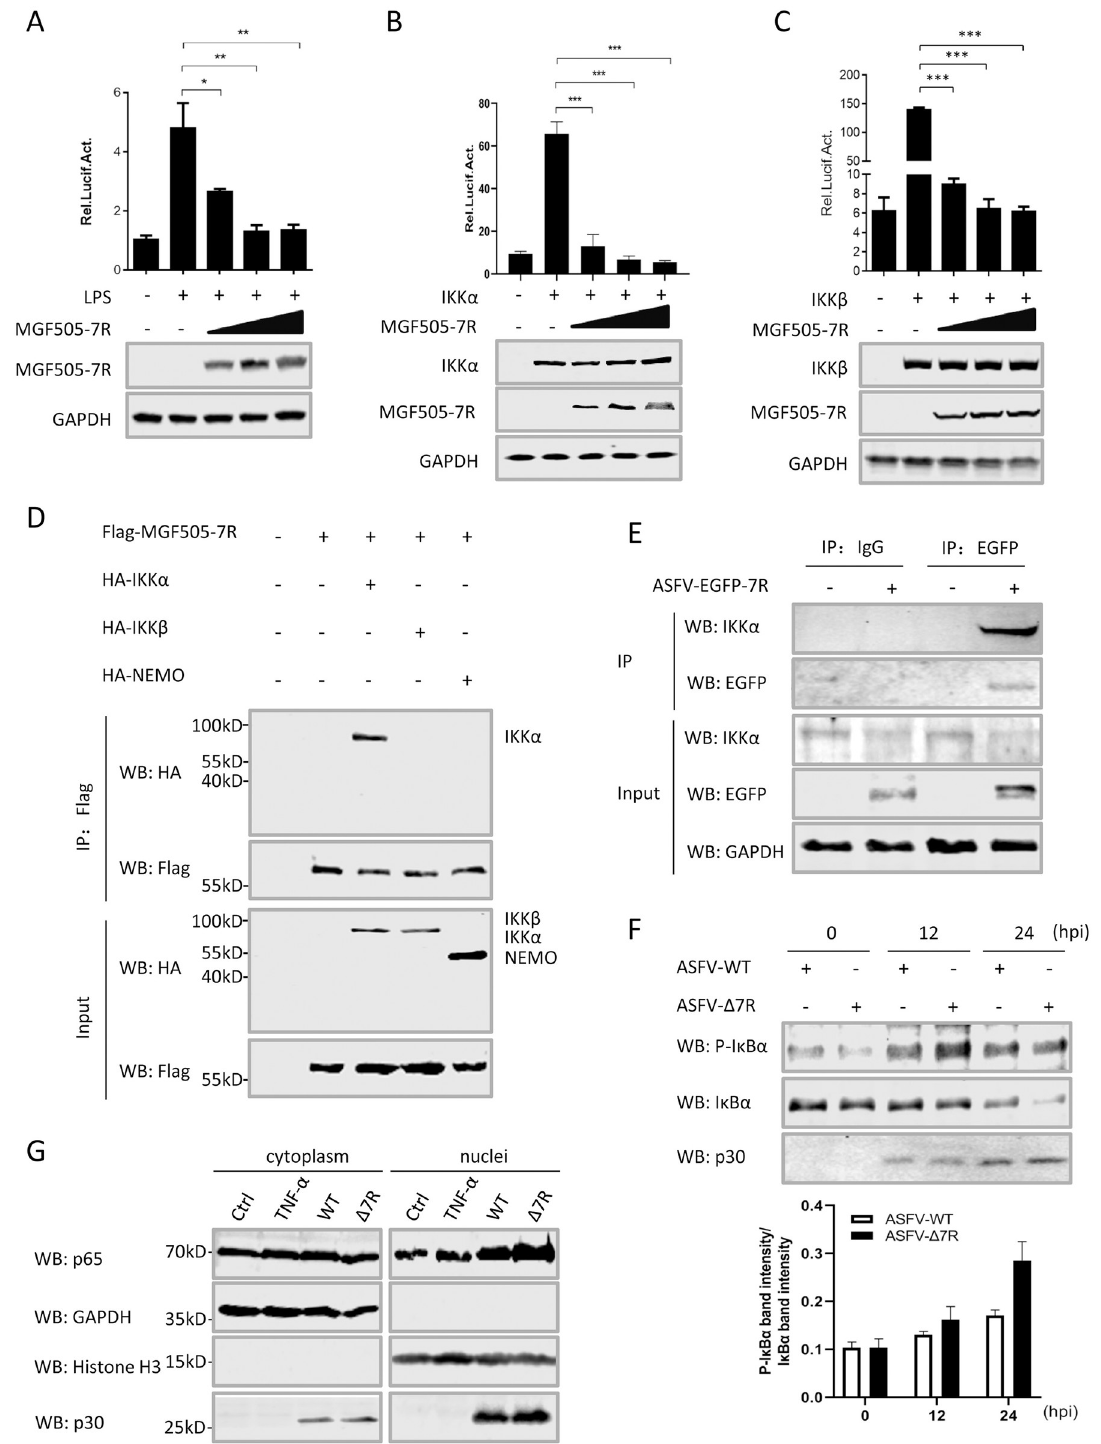
Fig 6. ASFV pMGF505-7R interacts with IKK complex to inhibit IL-1 β transcription. (A–C) HEK293T cells were transfected with NF- κ B reporter, increasing amounts of a plasmid encoding pMGF505-7R along with stimulation of LPS (100 ng/mL) (A) or a plasmid encoding IKK α (B) or IKK β (C) . The luciferase activities were measured. The expressions of IKK α , IKK β and pMGF505-7R were detected by Western blotting. GAPDH expressions were detected as a loading control. (D) HEK293T cells were transfected with a plasmid encoding Flag-tagged pMGF505-7R along with a plasmid encoding HA-tagged IKK α , IKK β or NEMO as indicated. 36 hpt, the